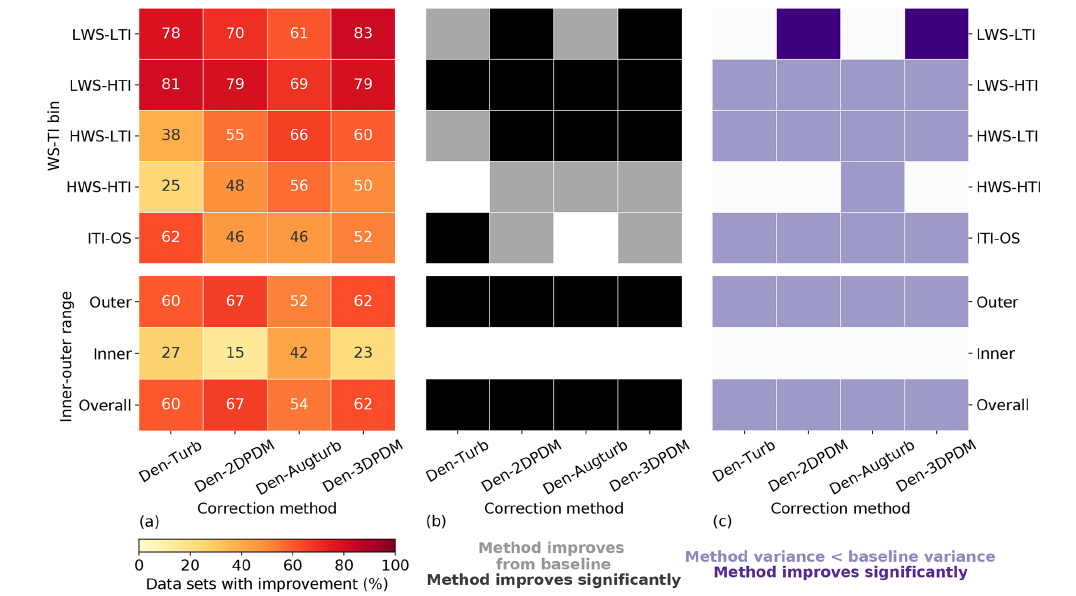
Figure 10. (a) Heat map of the four trial methods’ improvement fractions upon the baseline method for the four WS-TI bins and the ITI-OS bin in the outer range and the inner and outer ranges, calculated by combining the differences in absolute NMEs from individual submissions. The numbers in each cell indicate the individual improvement percentage. (b) Heat map illustrating whether a trial method yields a smaller absolute NME than the baseline on average in each data bin (grey) or not (white) and whether the result is statistically significant after performing the one-sided matched-pair t test with an alpha of 0.05 (black). (c) Heat map representing whether the NME variance of a trial method is smaller than the NME variance of the baseline method in each data bin (light purple) or not (white) and whether the result is statistically significant after performing the Levene’s test with an alpha of 0.05 (dark